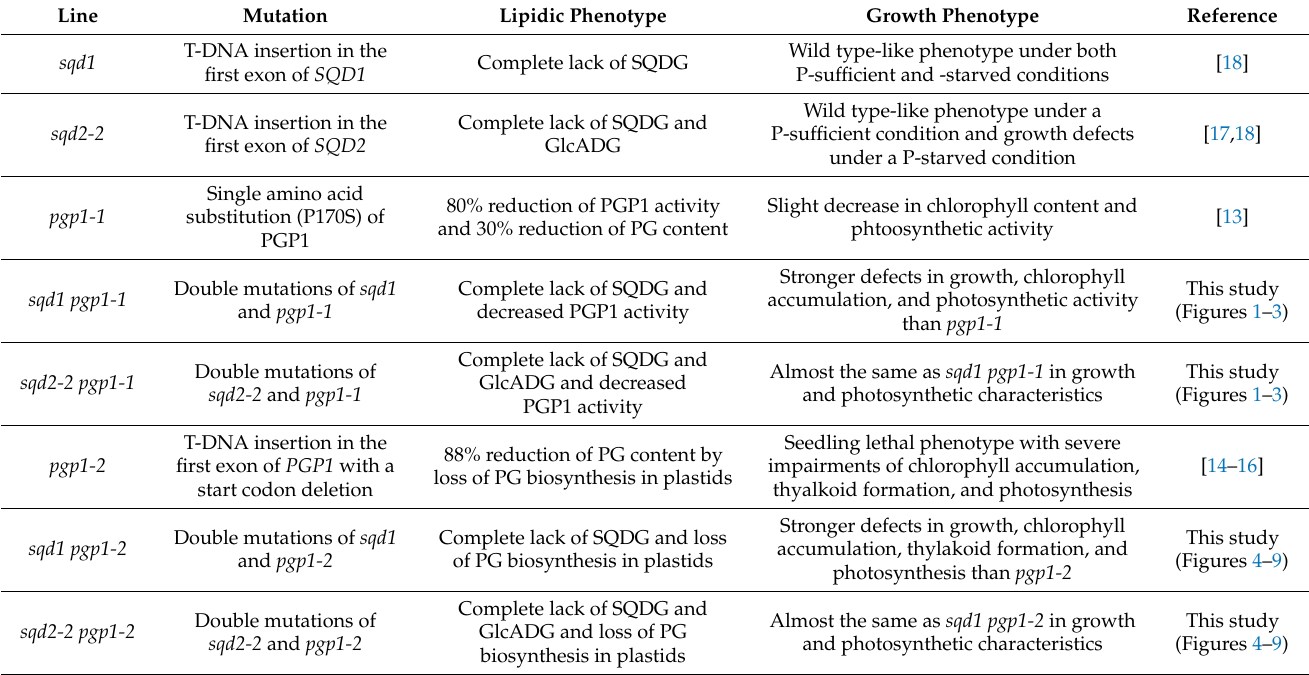
Table 1. Arabidopsis mutants deficient in plastid anionic lipid biosynthesis used in this study. Line Lipidic Phenotype Growth